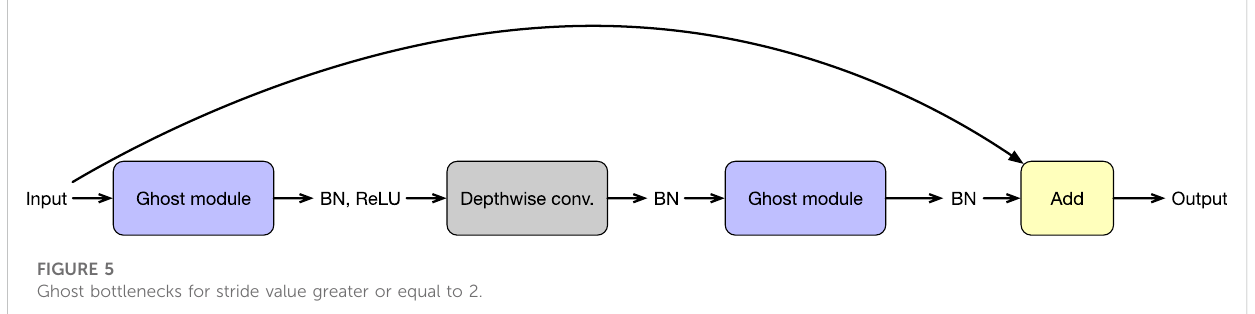
FIGURE 5 Ghost bottlenecks for stride value greater or equal to 2.